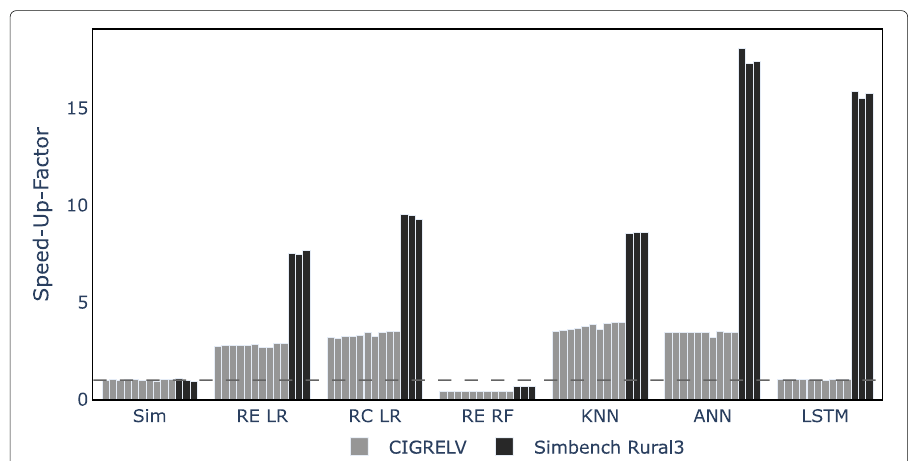
Fig. 2 Comparison of speed- up factors over all calculation times. The bars on the far left are the simulation models (Sim) and the reference for the other models. Higher is